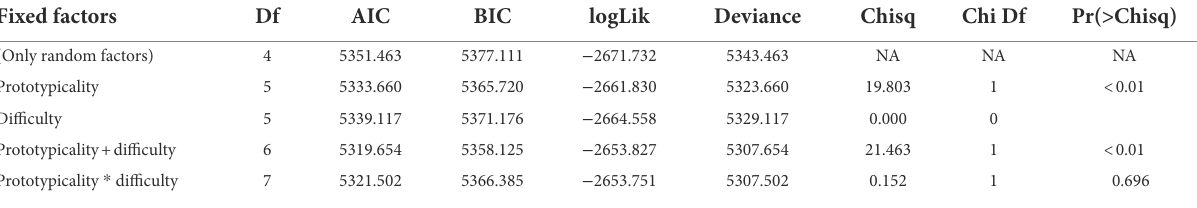
TABLE 2 The criteria used to compare the candidate models for the discrimination dataset in Experiment 2.